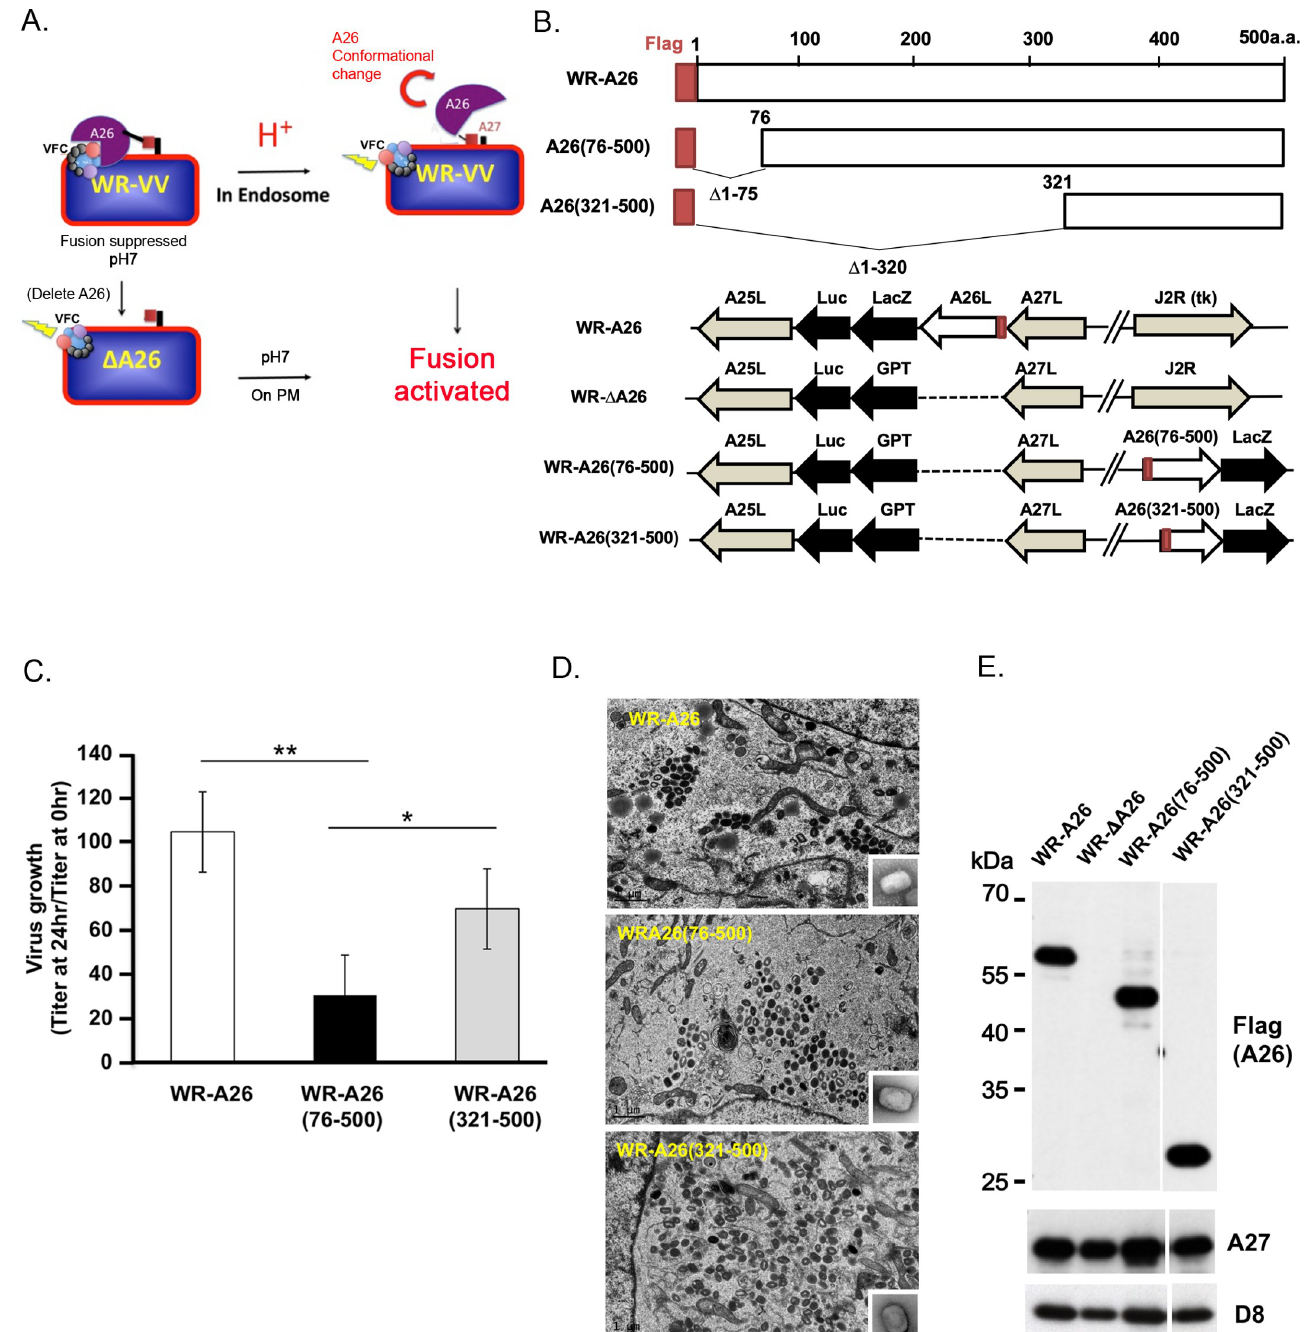
Fig 1. Model of A26 protein function and generation of mutant vaccinia viruses containing N-terminal deletions of A26 protein. (A) . Current model of how A26 protein functions as an acid-sensitive fusion suppressor of the WR strain of vaccinia virus MV. Vaccinia MV contains A26 protein that binds to the A16 and G9 components of the viral fusion complex (VFC) to suppress virus membrane fusion activity, which keeps the virus stable at neutral pH. When MV is internalized into endosomes, acidification triggers conformational changes of A26 protein that dissociates itself from the VFC, resulting in activation of the VFC and fusion of the viral and vesicular membranes. However, deletion of the A26L gene results in WR- Δ A26 MV particles lacking fusion suppressor activity, so these MV particles readily fuse to the plasma membrane (PM) at neutral pH. (B). Schematics of full-length WR-A26 and truncated WR-A26 proteins (aa 76–500 or 321–500), as well as each construct containing flag-tag sequences (red) at their N-termini. Locations of A26L mutant genes in the corresponding viral genomes are also shown. WR-A26 and WR- Δ A26 were described previously [32, 33], and the latter was used as the parental virus to generate the WR-A26(76–500) and WR-A26(321–500) recombinant viruses. The J2R locus encodes a non-essential viral thymidine kinase ( tk ). We inserted A26(76–500) and A26(321–500) gene